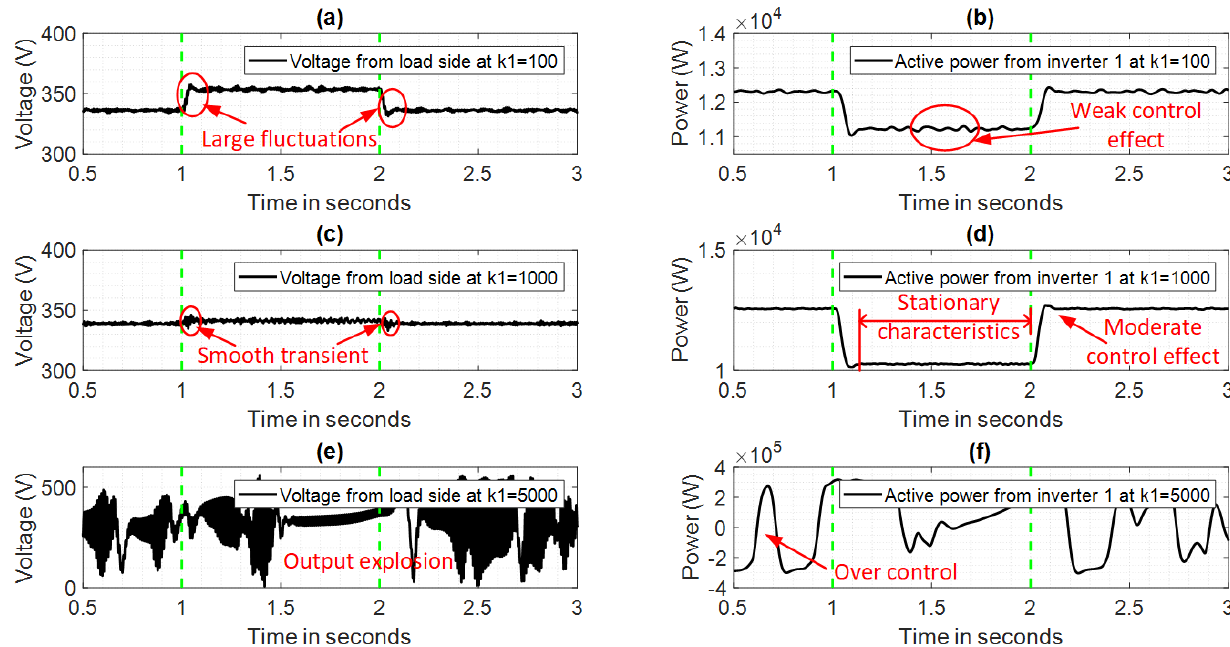
Figure 14. (cid:1863) (cid:2869) varying result. ( a ) Measured voltage in inverter 1 when (cid:1863) (cid:2869) = 100 , ( b ) measured active power in inverter 1 Figure 14. k 1 varying result. ( a ) Measured voltage in inverter 1 when k 1 = 100, ( b ) measured active power in inverter when (cid:1863) (cid:2869) = 100 , ( c ) measured voltage in inverter 1 when (cid:1863) (cid:2869) = 1000 , ( d ) measured active power in inverter 1 when (cid:1863) (cid:2869) = 1 when k 1 = 100, ( c ) measured voltage in inverter 1 when k 1 = 1000, ( d ) measured active power in inverter 1 when 1000 , ( e ) measured voltage in inverter 1 when (cid:1863) (cid:2869) = 5000 , ( f ) measured active power in inverter 1 when (cid:1863) (cid:2869) = 5000 . k 1 = 1000, ( e ) measured voltage in inverter 1 when k 1 = 5000, ( f ) measured active power in inverter 1 when k 1 =